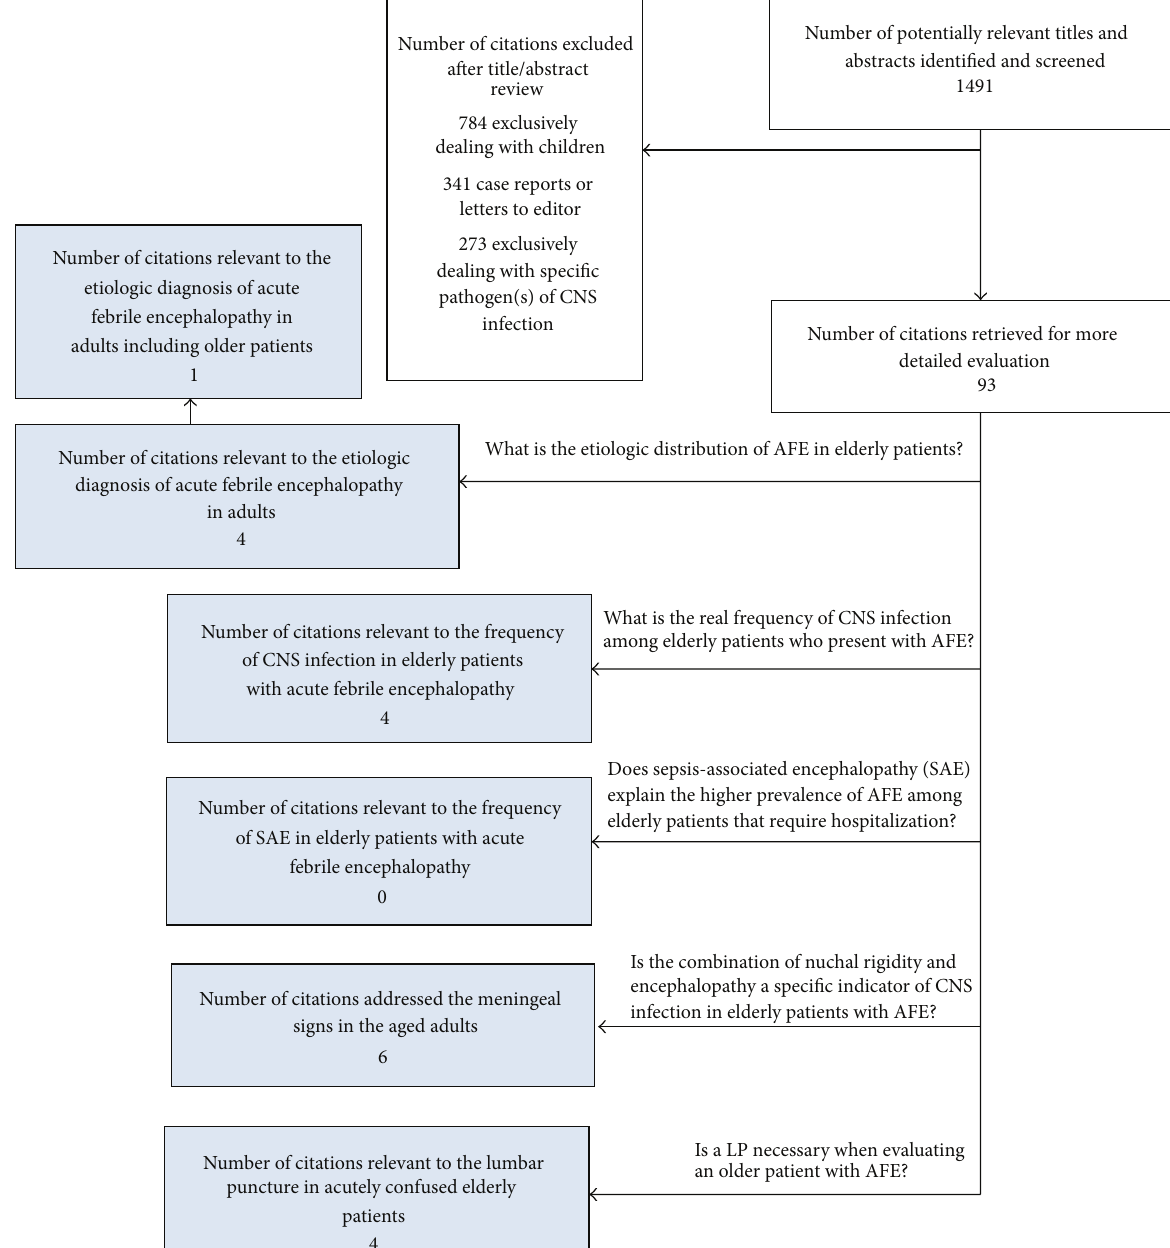
Figure 1: Relevant studies identified from the literature search. CNS: central nervous system; LP: lumbar puncture; SAE: sepsis-associated encephalopathy; and AFE: acute febrile